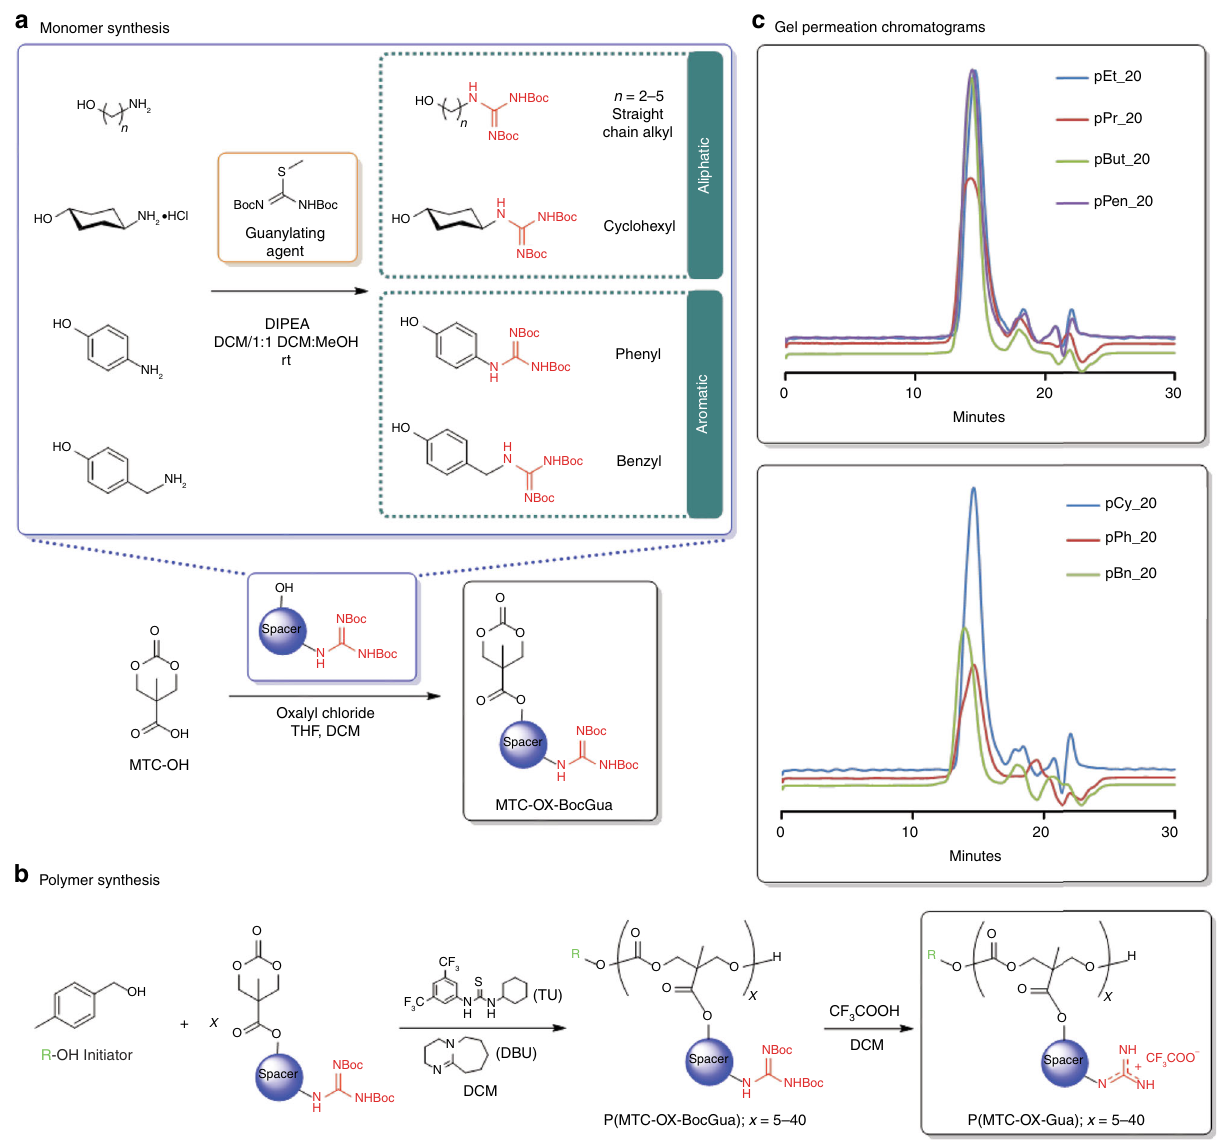
Fig. 1 Synthesis of monomers and polymers. a General scheme for the modular synthesis of Boc-protected guanidine-functionalized cyclic carbonate monomers (MTC-OX-BocGua) bearing various hydrophobic spacer groups; b general scheme for synthesis of guanidinium-functionalized polycarbonates (P(MTC-OX-Gua)) by metal-free ROP followed by acid-mediated removal of Boc groups; c GPC chromatograms of representative polycarbonates (prior to